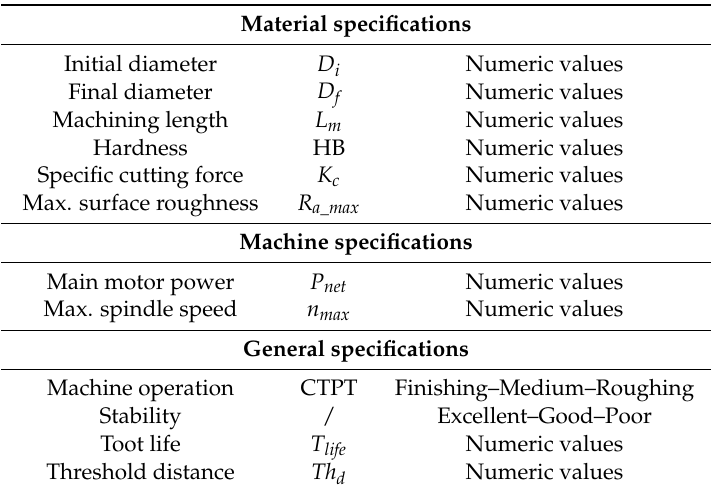
Table 5. Working specifications.